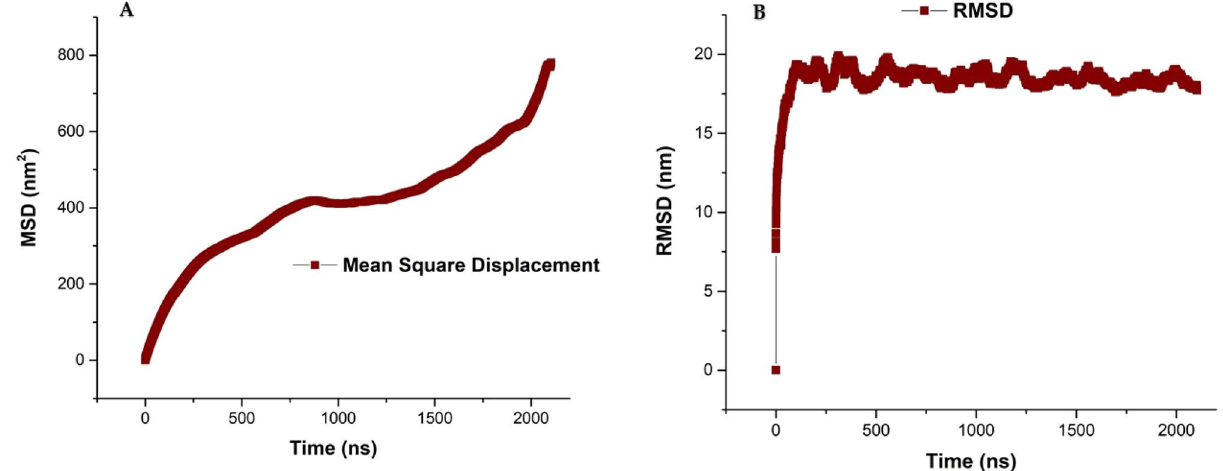
Figure 9. ( A ) The MSD of DOPC–DOPE lipids of the formed vesicle. ( B ) The root-mean-square deviation (RMSD) for DOPC–DOPE lipids of the formed